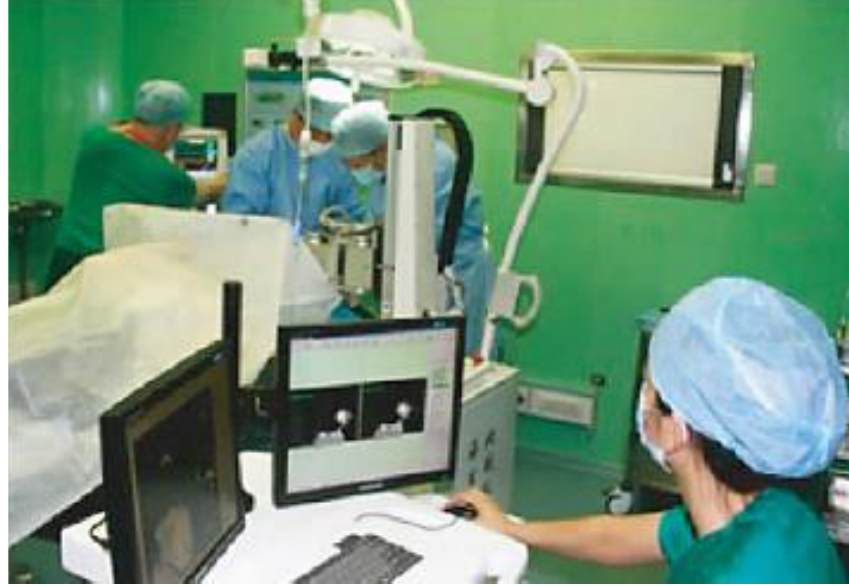
Figure 1. BH-7 robot.